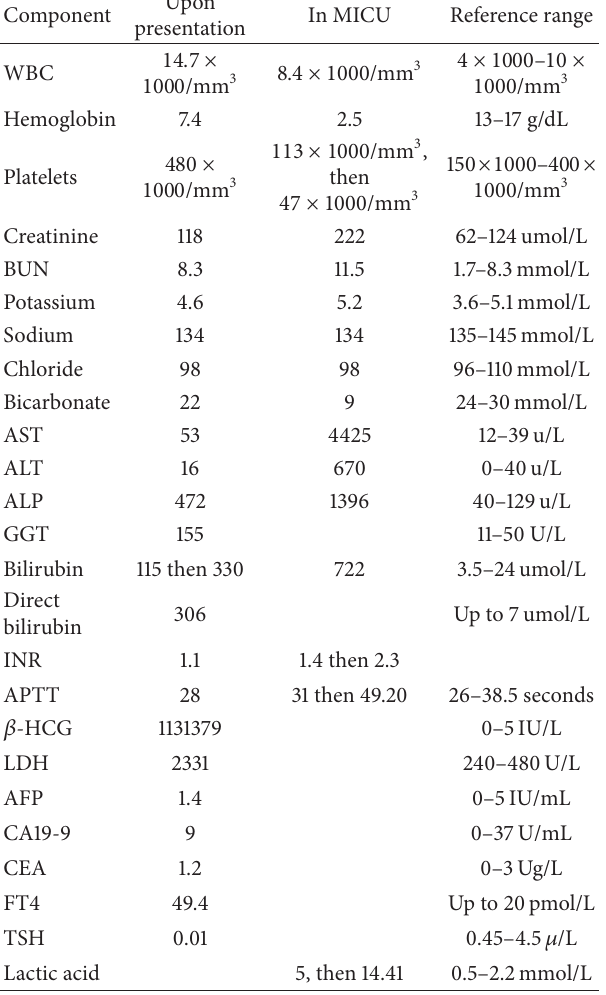
Table 1: Investigations done during the patient hospitalization. Component